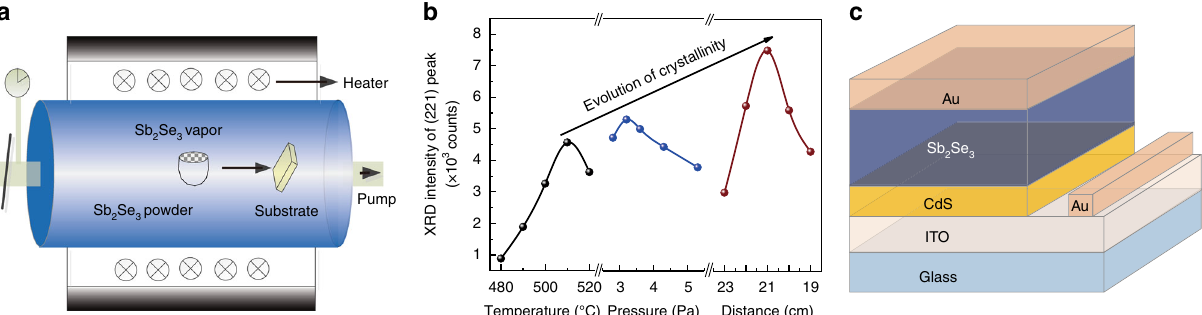
Fig. 1 Fabrication of CdS/Sb 2 Se 3 solar cells. a Schematics of our VTD system. b Evolution of crystallinity with the optimization of deposition condition. c The device structure of our Sb 2 Se 3 solar